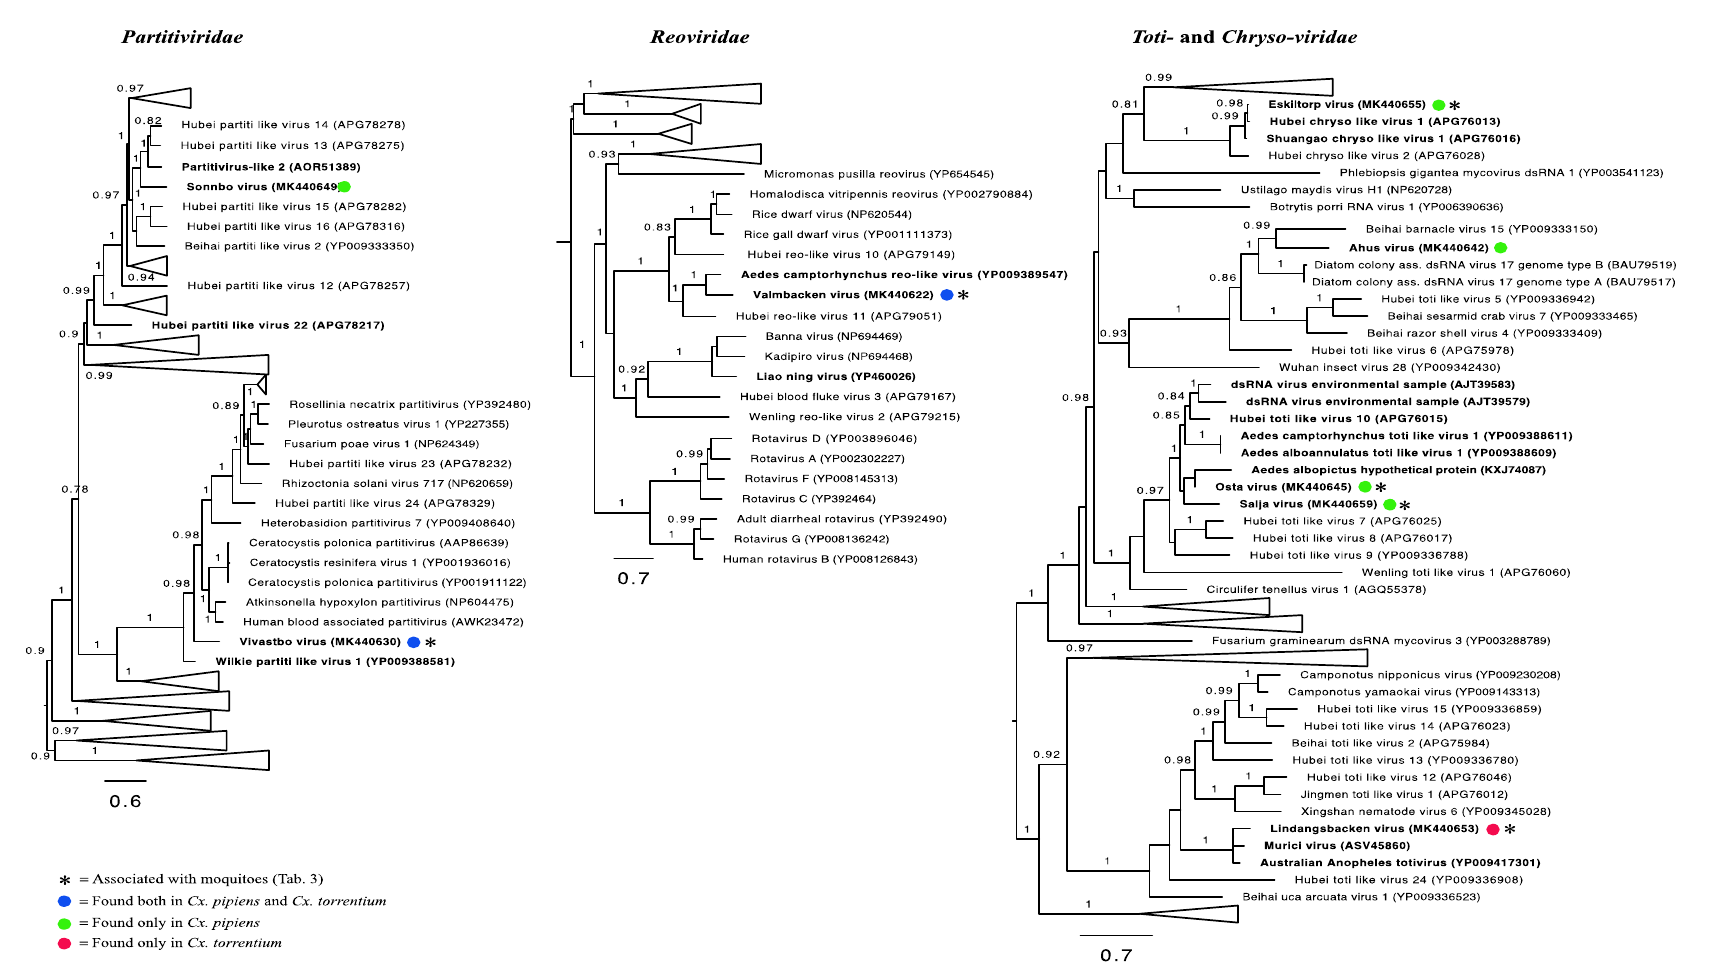
Figure 6. Phylogenetic analysis of all the double-stranded RNA viruses identified here (marked by colored circles) along with representative publicly available viruses. Those viruses most likely associated with mosquitoes are marked by an *. Numbers on branches indicate SH support, and only branches with SH support ≥ 80% are indicated. Branch lengths are scaled according to the number of amino acid substitutions per site. All phylogenetic trees were midpoint-rooted for clarity only. Known mosquito-associated viruses and virus sequences that were derived from mosquito samples are indicated in